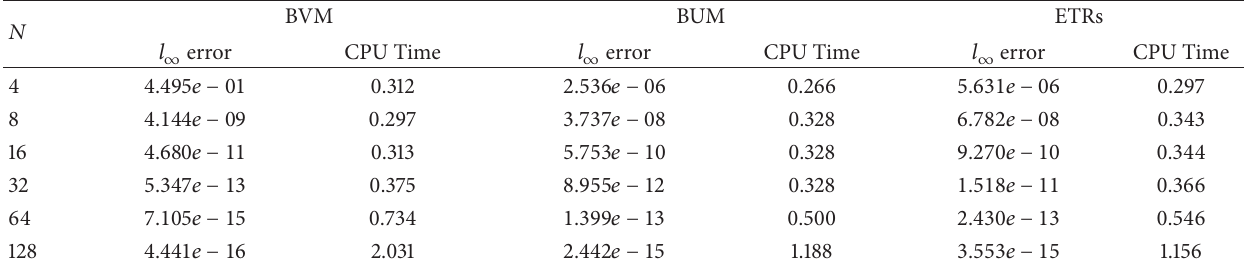
Table 5: Computational results for V = 2 for Example 5.3.